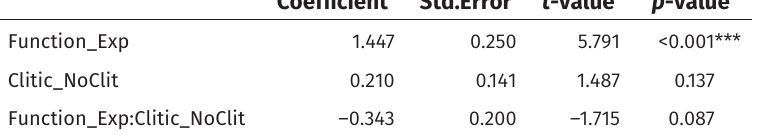
Table 3: Study 1 – Generalized linear mixed model fitted by using lmer function in the lme4 package (with Gaussian